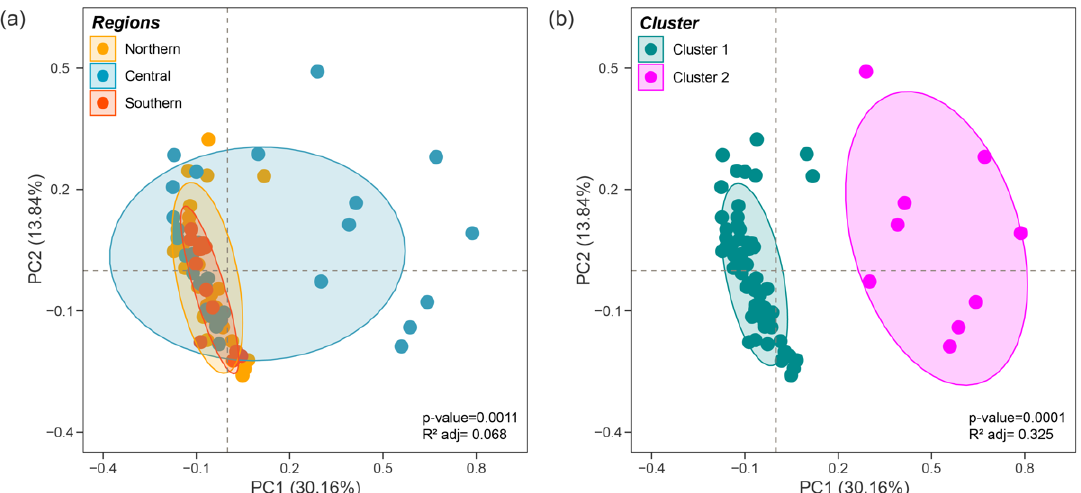
Figure 3. PCoAs based on Bruvo’s genetic distances calculated between Ilex guayusa individuals genotyped with 17 SSR markers. The first two axes represent 44% of the total variation. ( a ) Individuals grouped according to the region of origin: Northern (orange), Central (blue), and Southern (red); ( b ) individuals grouped according to the genetic clusters inferred with the DAPC: Cluster 1 (teal), Cluster 2 (pink).